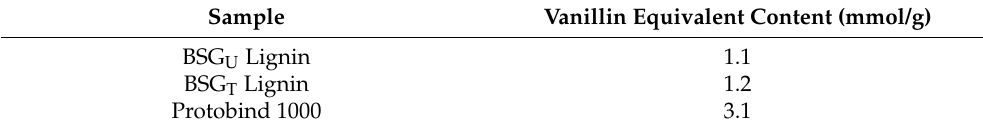
Table 6. Results of the determination of phenolic hydroxyl groups expressed as vanillin equiva- lents/g of lignin sample. Estimated standard errors ± 0.2 mmol/g vanillin equivalent (1 σ , from calibration